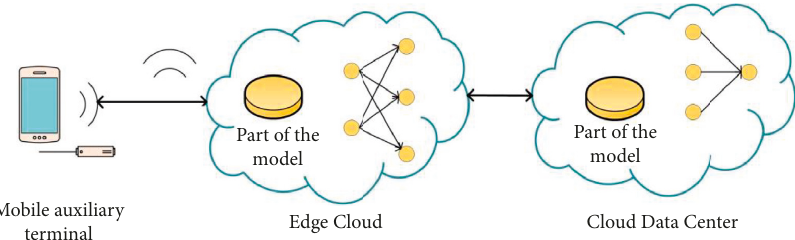
Figure 2: Teaching assistance system based on edge cloud and mobile AIDS.